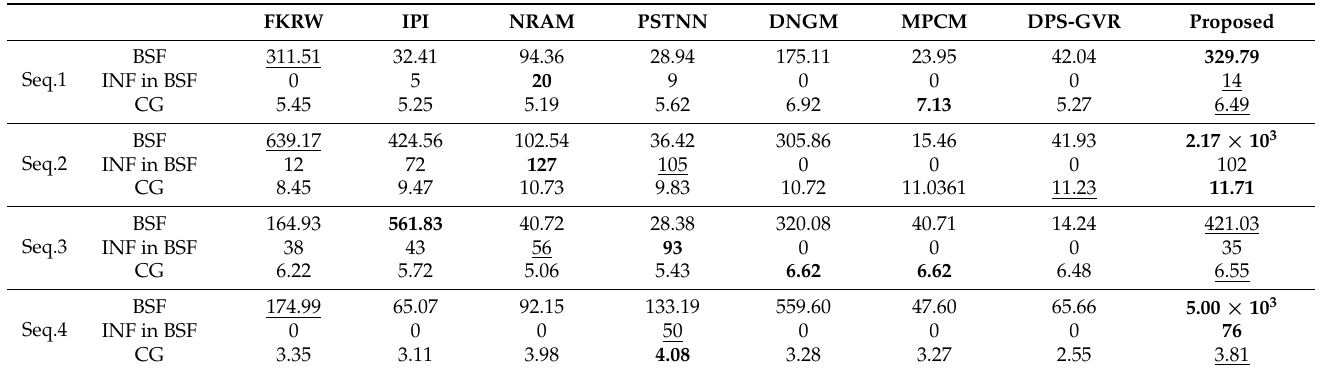
Table 4. Average BSF and CG using different methods on four sequences. The best-obtained results are bolded, and the second-best results are